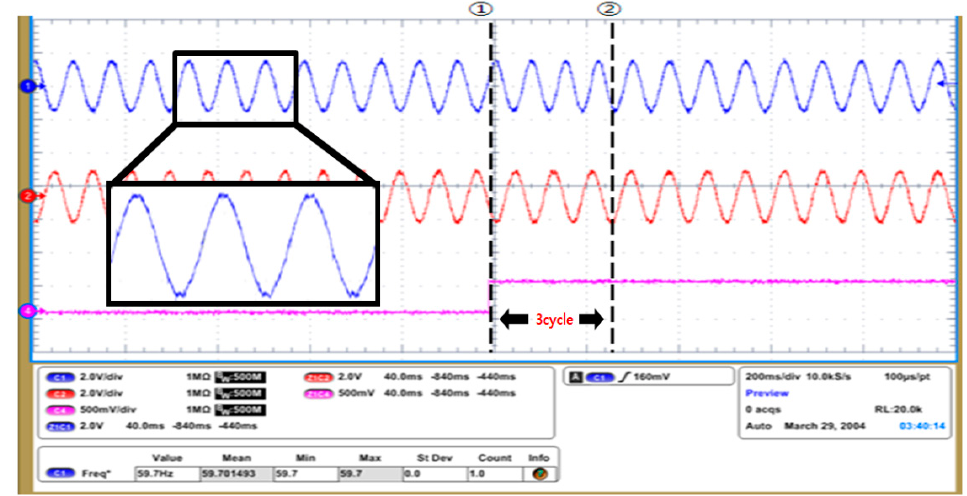
Figure 20. Experimental results in Case I (SBGS ⟶ GS Mode). (From top to bottom: Measured a -phase inverter output voltage and grid voltage (200 V/div), and GS status signal (0 or 1)) ( ① : starting point of synchronization. ② : finalized point of synchronization).